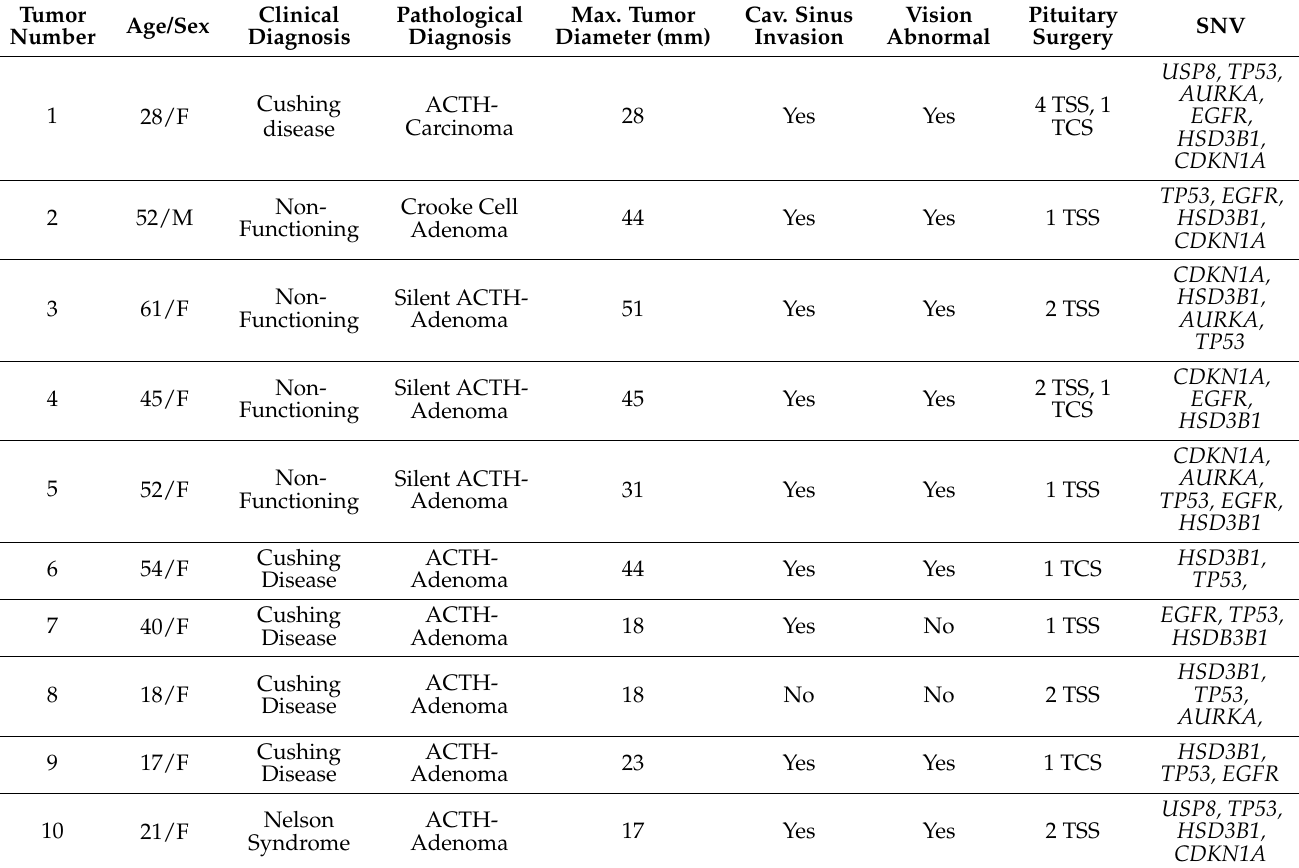
Table 1. Clinical features of the tumors analyzed and SNV present in each